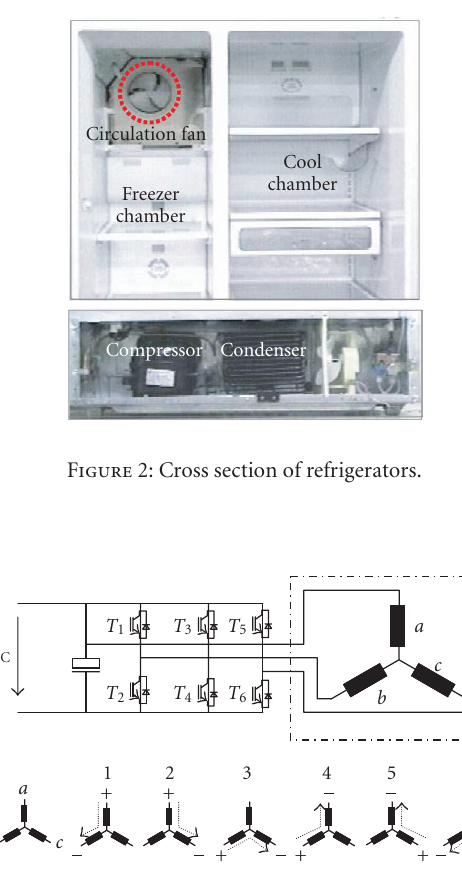
Figure 3: Block diagram of three-phase BLDC motor and six-step commutation